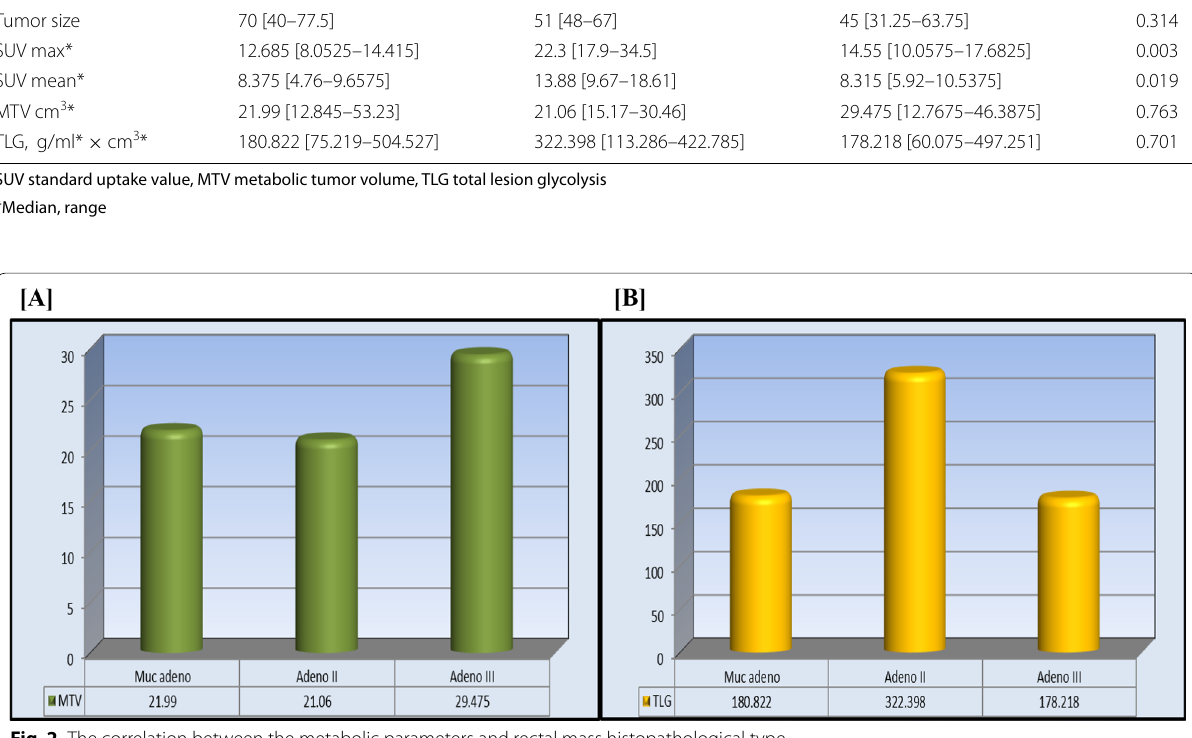
Fig. 2 The correlation between the metabolic parameters and rectal mass histopathological